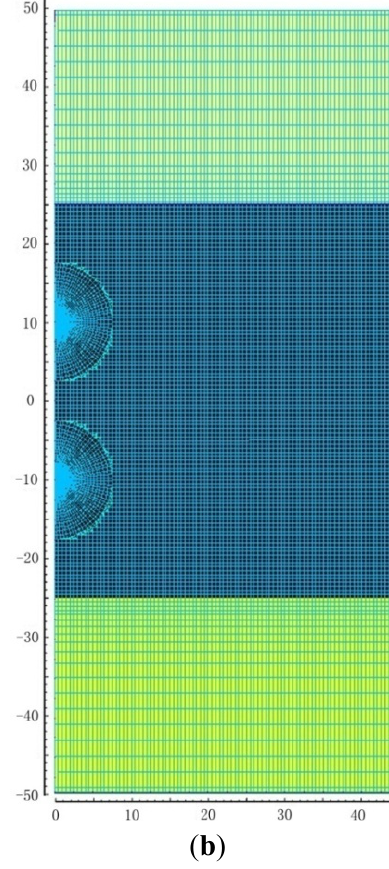
Figure 2. ( a ) Schematic of the marine hydrate reservoir in the South China Sea; ( b ) The corresponding 2-D hybrid